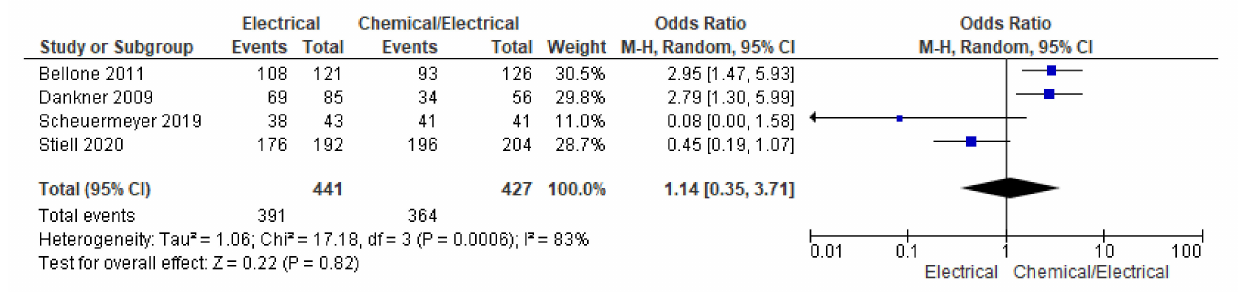
Figure 3. Forest plot showing cardioversion across electrical and chemical followed by electrical cardioversion group using random effect model [2,3,11,12].